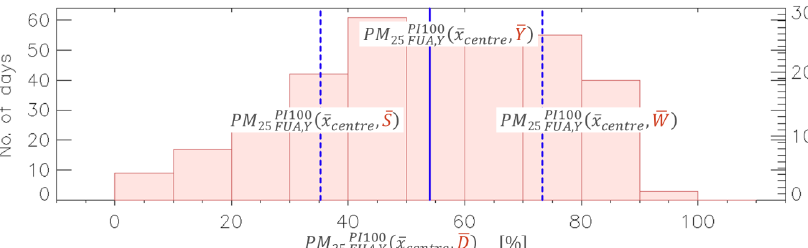
Figure 7. Frequency histogram of daily potential impact at 100% (PI100) modelled with the EMEP model for the city of Madrid. Each column represents the number of days with a given daily PI. The blue line provides the yearly average PI. For these calculations, the source is the Madrid functional urban area (FUA) over which emissions are switched off during the whole year ( Y ). The indicator is the total PM 2 . 5 mass. The receptor point is the city centre location ( x centre